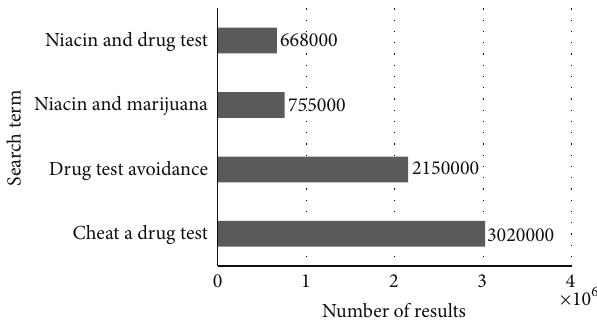
Figure 1: Results of a Google search regarding topics related to niacin and drug